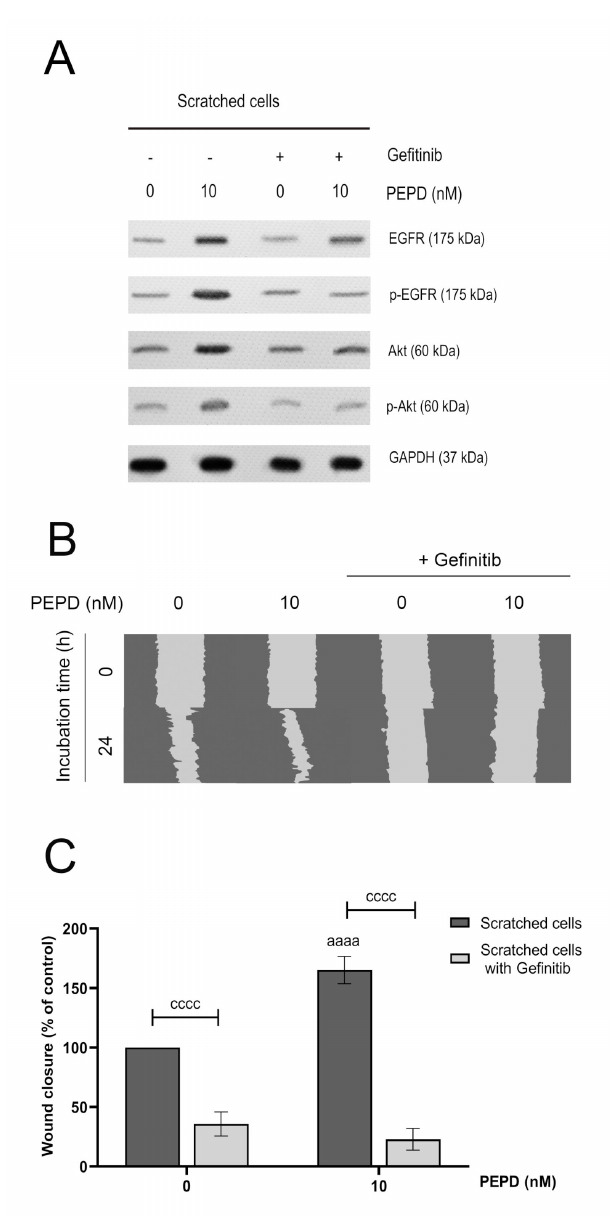
Figure 5. Prolidase elicits migration in HaCaT cells through EGFR. ( A ) The level of expression of EGFR and Akt proteins analyzed by Western immunoblotting in lysates of scratched HaCaT cells incubated with PEPD (10 nM) and an inhibitor of EGFR (Gefitinib, 2 µ M) for 30 min and 24 h. Representative blot images are shown (densitometric analysis of presented protein is included in Supplementary Materials (Supplementary Figure S4)). ( B ) Prolidase- and Gefitinib-treated keratinocytes were scratched and monitored using an inverted microscope at 0 and 24 h of incubation. Supplementary Materials contain microscopic images in triplicates (Supplementary Figure S5). ( C ) The wound closure rate of scratched HaCaT cells was evaluated by ImageJ software. The results represent mean ± SEM of three replicates and are significant aaaa , or cccc < 0.0001 and are marked as a vs. control (0 nM of PEPD) of scratched cells, b vs. control (0 nM of PEPD) of scratched cells after treated with Gefitinib, and c marked scratched cells vs. scratched cells after treated with Gefitinib in the same concentration of PEPD,